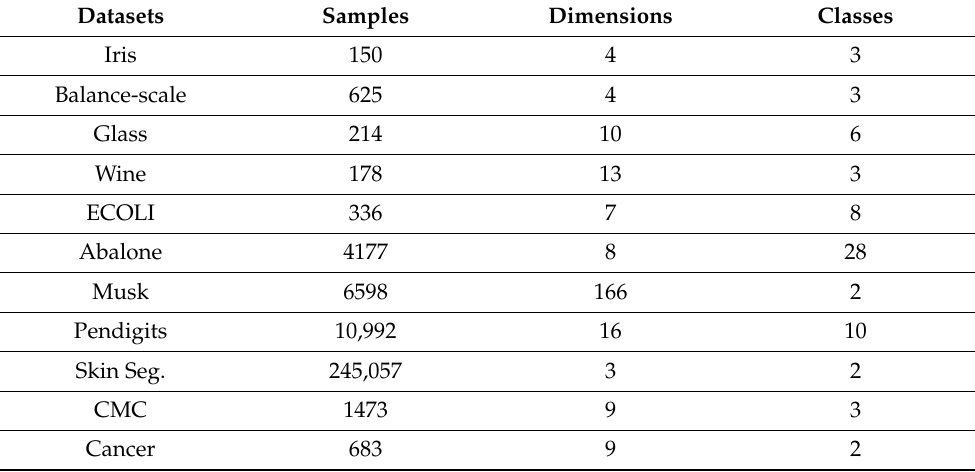
Table 5. The datasets downloaded from UCI Machine Learning